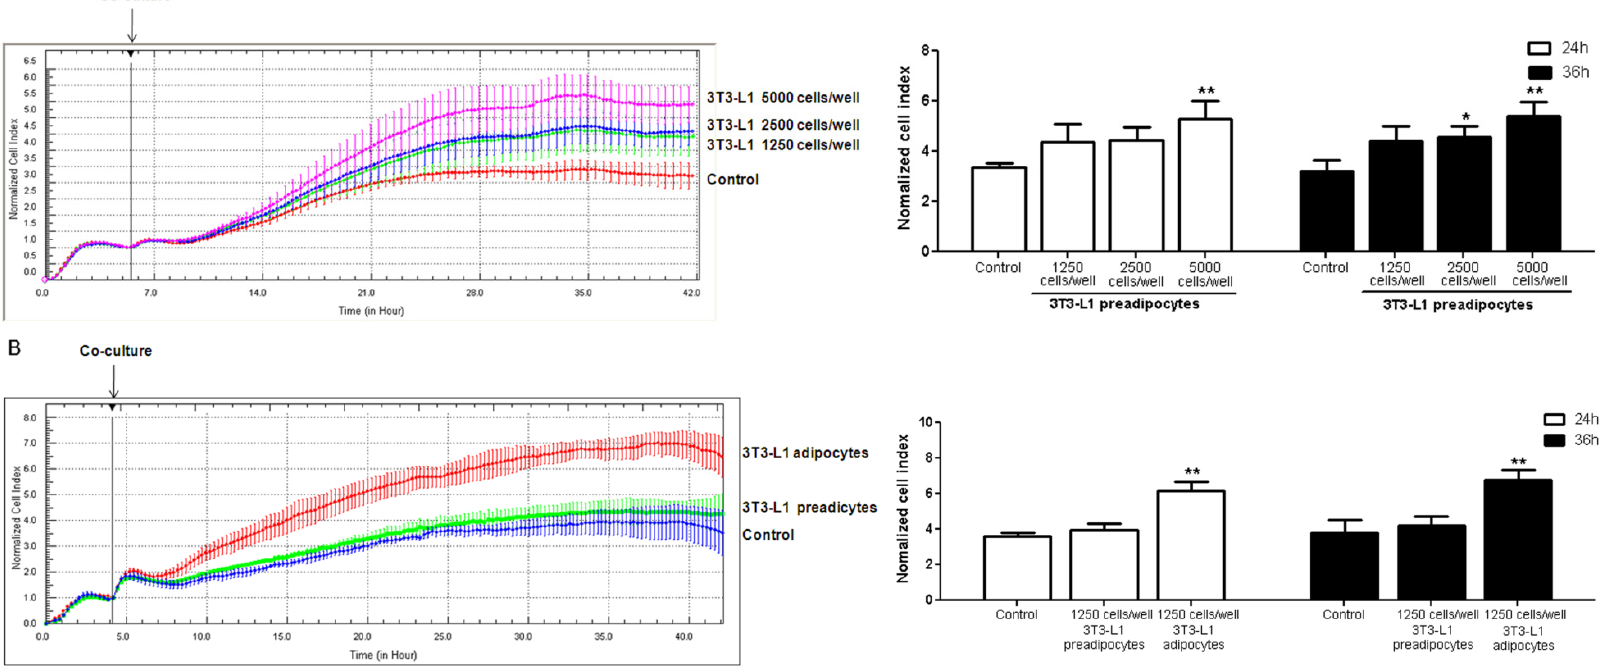
Figure 6. Real-time monitoring of human umbilical vein endothelial cells (HUVECs) cultured with 3T3-L1 cells. HUVECs were seeded into E-plates at equal densities of 6000 cells/well. ( A ) 3T3-L1 preadipocytes seeded at different densities into the insert; ( B ) 3T3-L1 preadipocytes and 3T3-L1 adipocytes seeded into E-plates at equal densities of 1250 cells/well. There were no cells in the insert of control group. After adherence, the insert was added into the E-plates containing HUVECs. Changes in cell index were normalized to the time of co-culture. Experiments were performed in triplicates. The error bars represent the standard deviation (SD) ( n = 3); * p < 0.05, ** p < 0.01 vs. the control.